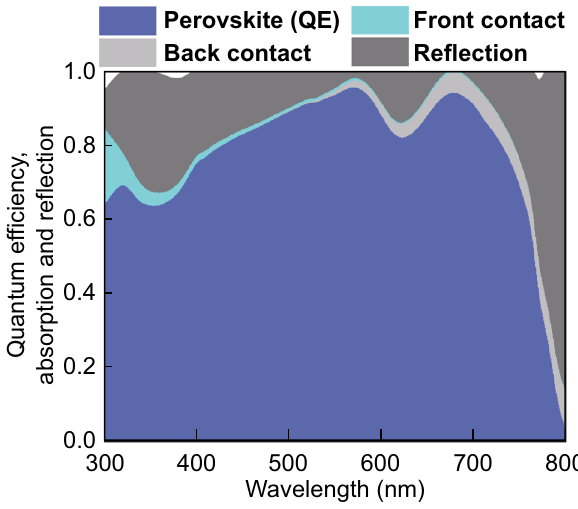
Fig. 11 Quantum efficiency and absorption of individual layers of a planar perovskite solar